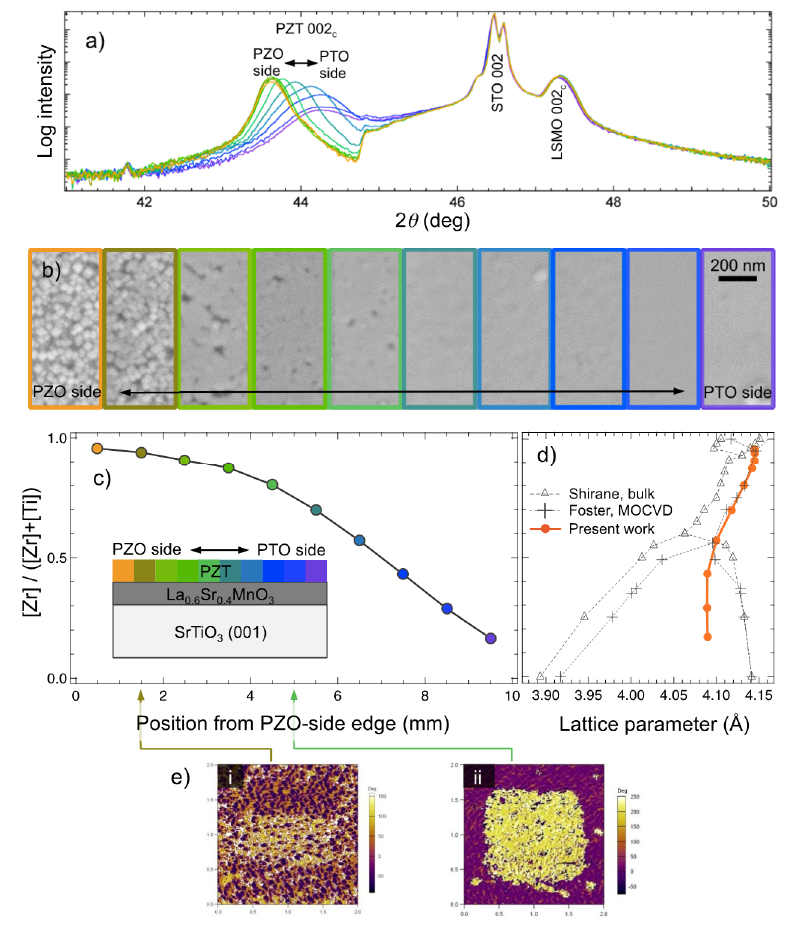
Figure 4. XRD 2 θ – ω profiles ( a ), SEM images ( b ), and Zr ratio [Zr] / ([Zr] + [Ti]) evaluated by XPS ( c ), at 10 points on a (1 − x )PbTiO 3 —x PbZrO 3 laterally composition gradient film. Colors of lines in ( a ), of frames in ( b ), and of symbols in ( c ) are corresponding with each other and representing the position on the film, as illustrated in the inset of ( c ). ( d ) Relationship of interplanar lattice spacing calculated from the 2 θ angles of PZT (002) c di ff raction peaks (Figure 4a) and Zr ratio (Figure 4c). Reported values of lattice parameters of PZT materials with various compositions in bulk samples [30] and on films grown on SrTiO 3 (001) by metal organic chemical vapor deposition (MOCVD) [31], are also shown for comparison. ( e ) PFM phase images after polarization at points 1.5 mm (i) and 5.0 mm (ii) from PZO-side edge. The observation area for each is 2 µ m × 2 µ